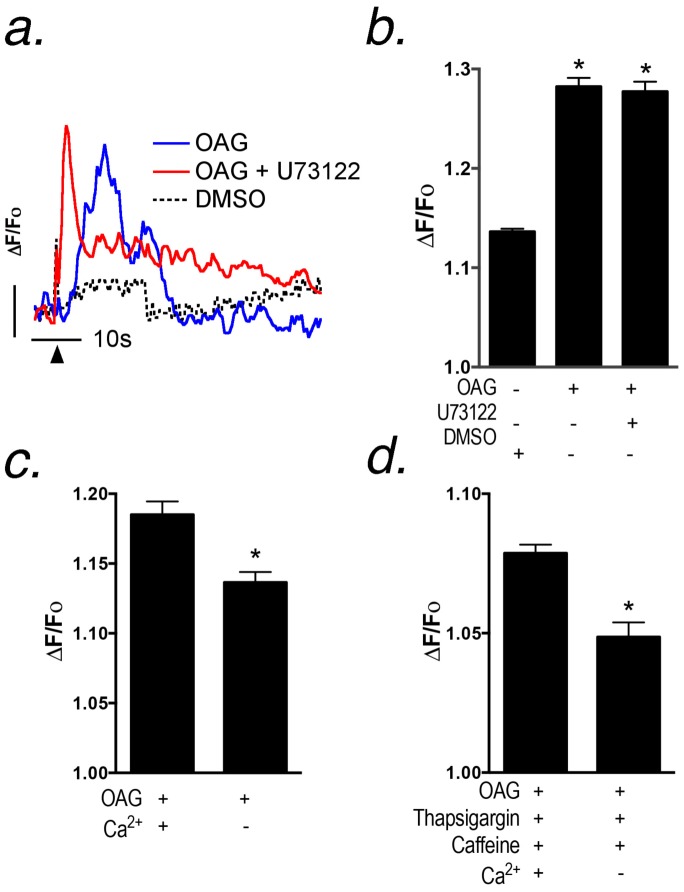
OAG activates Ca2+ transients in astrocytes independently of the phospholipase C - IP3 pathway that require extracellular Ca2+ but do not require Ca2+ release from intracellular stores.(a,b) Ca2+ transients were stimulated with 100 µM OAG in the presence or absence of the PLC inhibitor, U73122 (10 µM), or DMSO vehicle control. Quantification of peak amplitudes from (a) indicates that 10 µM U73122 had no inhibitory effect on OAG-induced Ca2+ transients, suggesting that OAG causes Ca2+ entry separate from the PLC-IP3 pathway. The vertical bar in (a) denotes 1 relative fluorescent unit; the horizontal bar denotes 10 sec. Black arrows denote the point of stimulation by 100 µM OAG. (c) Ca2+ transients were initiated with 100 µM OAG in the presence or absence of extracellular Ca2+, demonstrating a significant inhibition in OAG response with the removal of extracellular Ca2+. (d) Intracellular Ca2+ stores were depleted by successive additions of 10 µM thapsigargin and 5 mM caffeine prior to OAG-induced Ca2+ transients in order to determine the role of intracellular and extracellular Ca2+. Results indicate that prior depletion of intracellular Ca2+ stores had no effect on OAG-induced Ca2+ transients yet depletion of extracellular Ca2+ inhibited the amplitude of OAG-induced transients similar to (c). n = 500–700 cells for each experiment over 2–3 independent experiments in separate cultures of striatal astrocytes; *p<0.05.